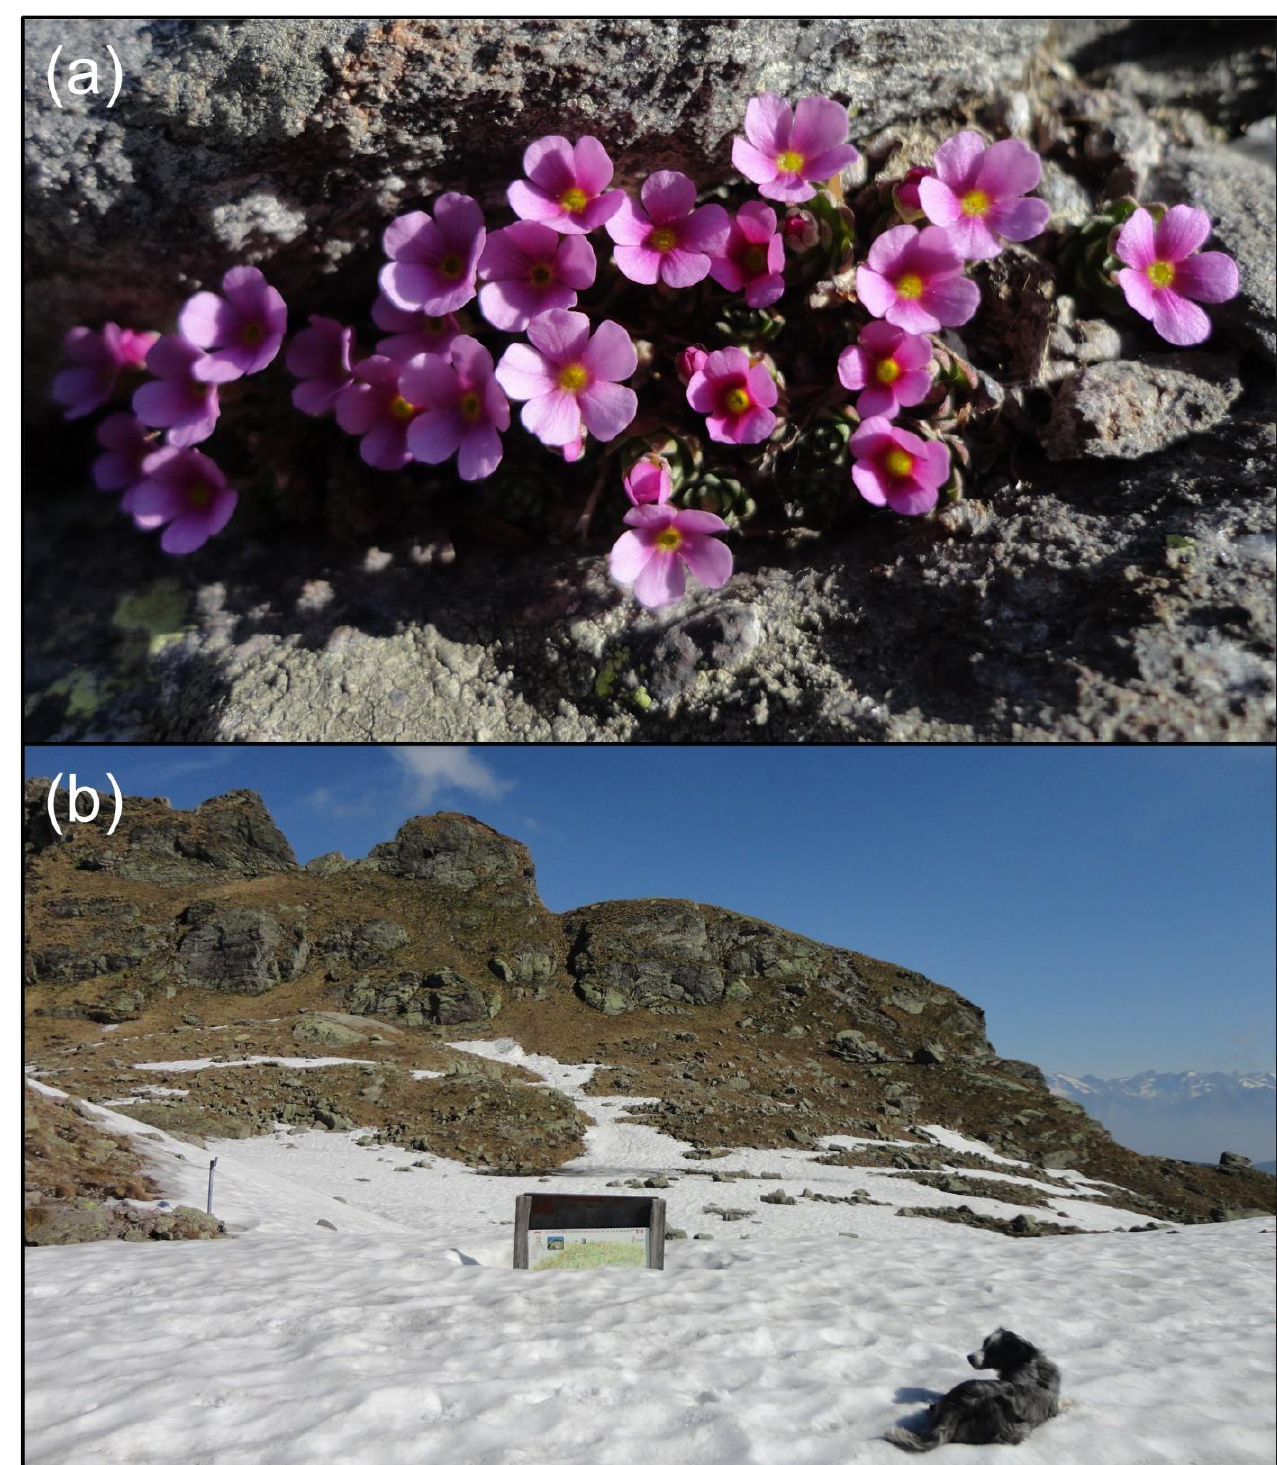
Figure 1. Androsace brevis ( a ) and snow cover during its flowering at the Mountain Hut ‘Cesare Benigni’ in the Orobic Alps (Bergamo, Lombardy) on 31 May 2017 ( b ).